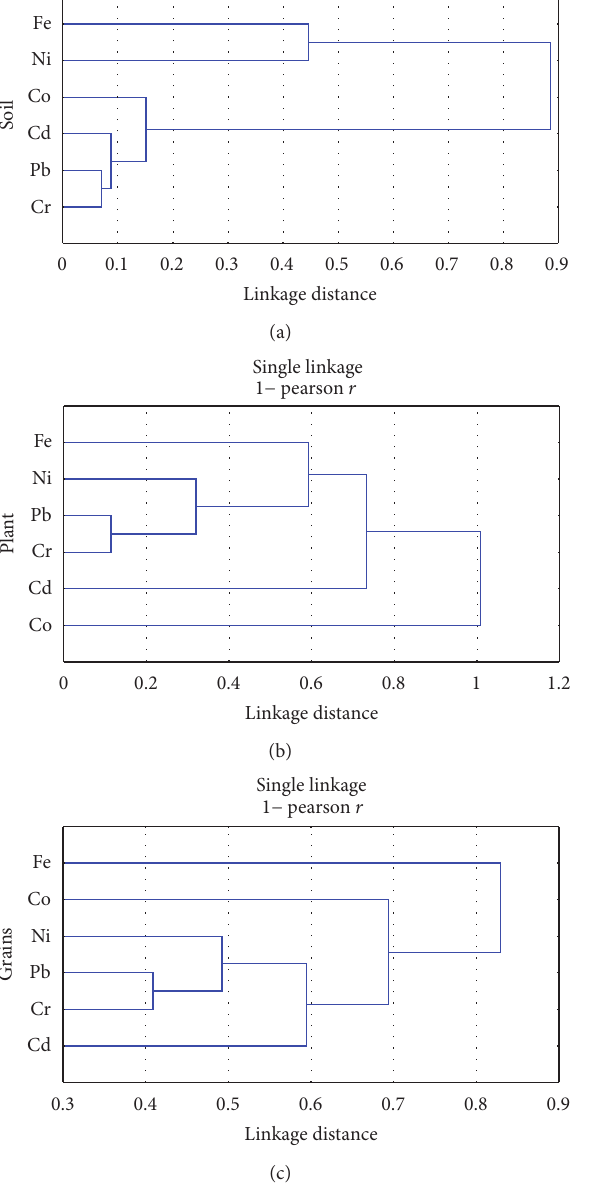
F 2: Cluster analysis of metals in soil, plants, and